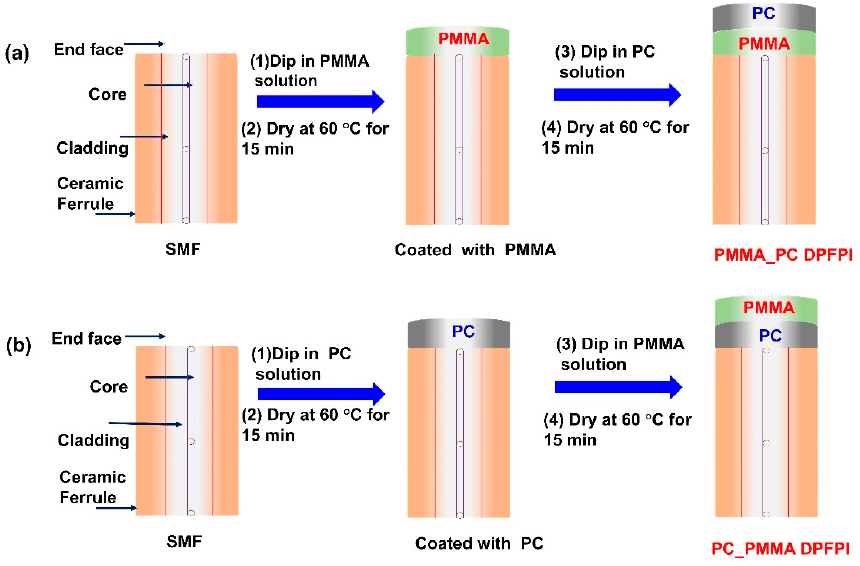
Figure 2. Representation of fabrication method of ( a ) PMMA_PC DPFPI and ( b ) PC_PMMA DPFPI temperature sensors.